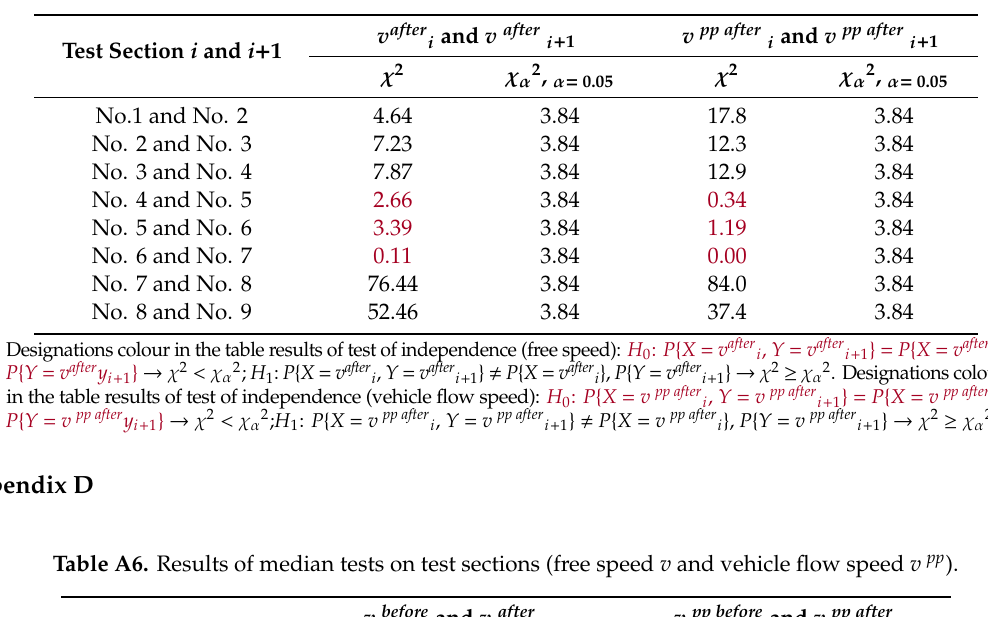
Designations colour in the table results of test of independence (free speed): H 0 : P { X = v before i , Y = v after i } = P { X = v before i }, P { Y = v after in the table results of test of independence (vehicle flow speed): H 0 : P { X = v ppbefore i , Y = v ppafter i } = P { X = v ppbefore i }, P { Y = v ppafter Table A5. Results of test of independence on subsequent test sections (free speed v after and vehicle flow speed v pp after ).